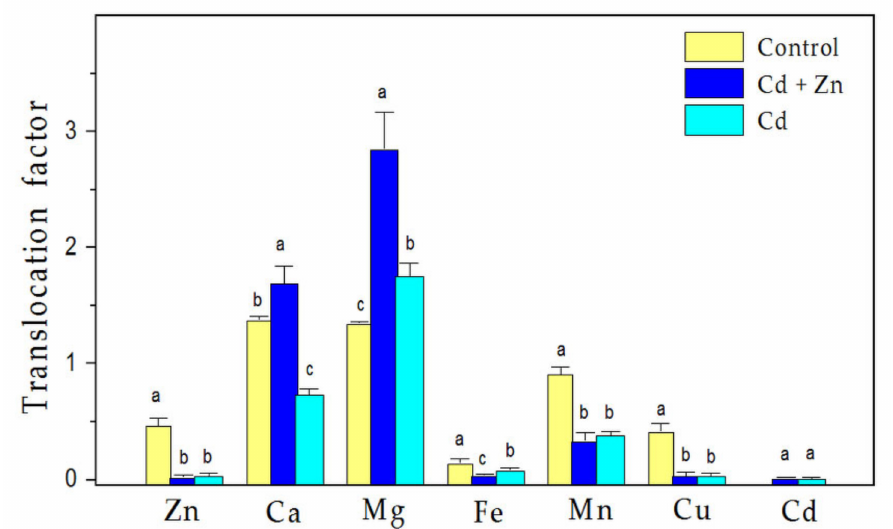
Figure 2. Changes in the translocation factors of the mineral elements in Salvia sclarea plants in response to 100 µ M Cd treatment with and without excess (900 µ M) Zn exposure for 8 days. Mean values ( ± SD, n = 3) were compared between the treatments for the same element performing one-way ANOVA analysis. Different letters indicate significant differences between the values for the same element at p < 0.05 using Fisher’s LSD post-hoc